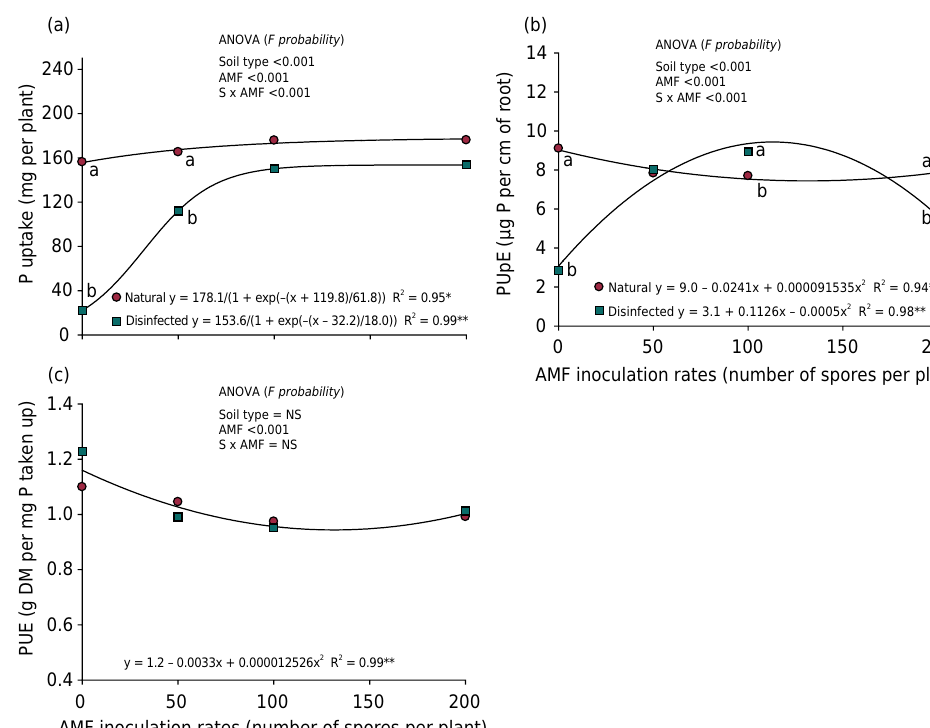
Figure 5. Amount of P taken up (a), P uptake efficiency (PUpE) (b) and P use efficiency (PUE) (c) by the cassava in response to AMF inoculation rates in natural and disinfected soils. Within each AMF inoculation rate, different lowercase letters indicate a significant difference between soil types, whereas the absence of lowercase letters indicates a non-significant difference between soil types at p≤0.05. * p≤0.05; **